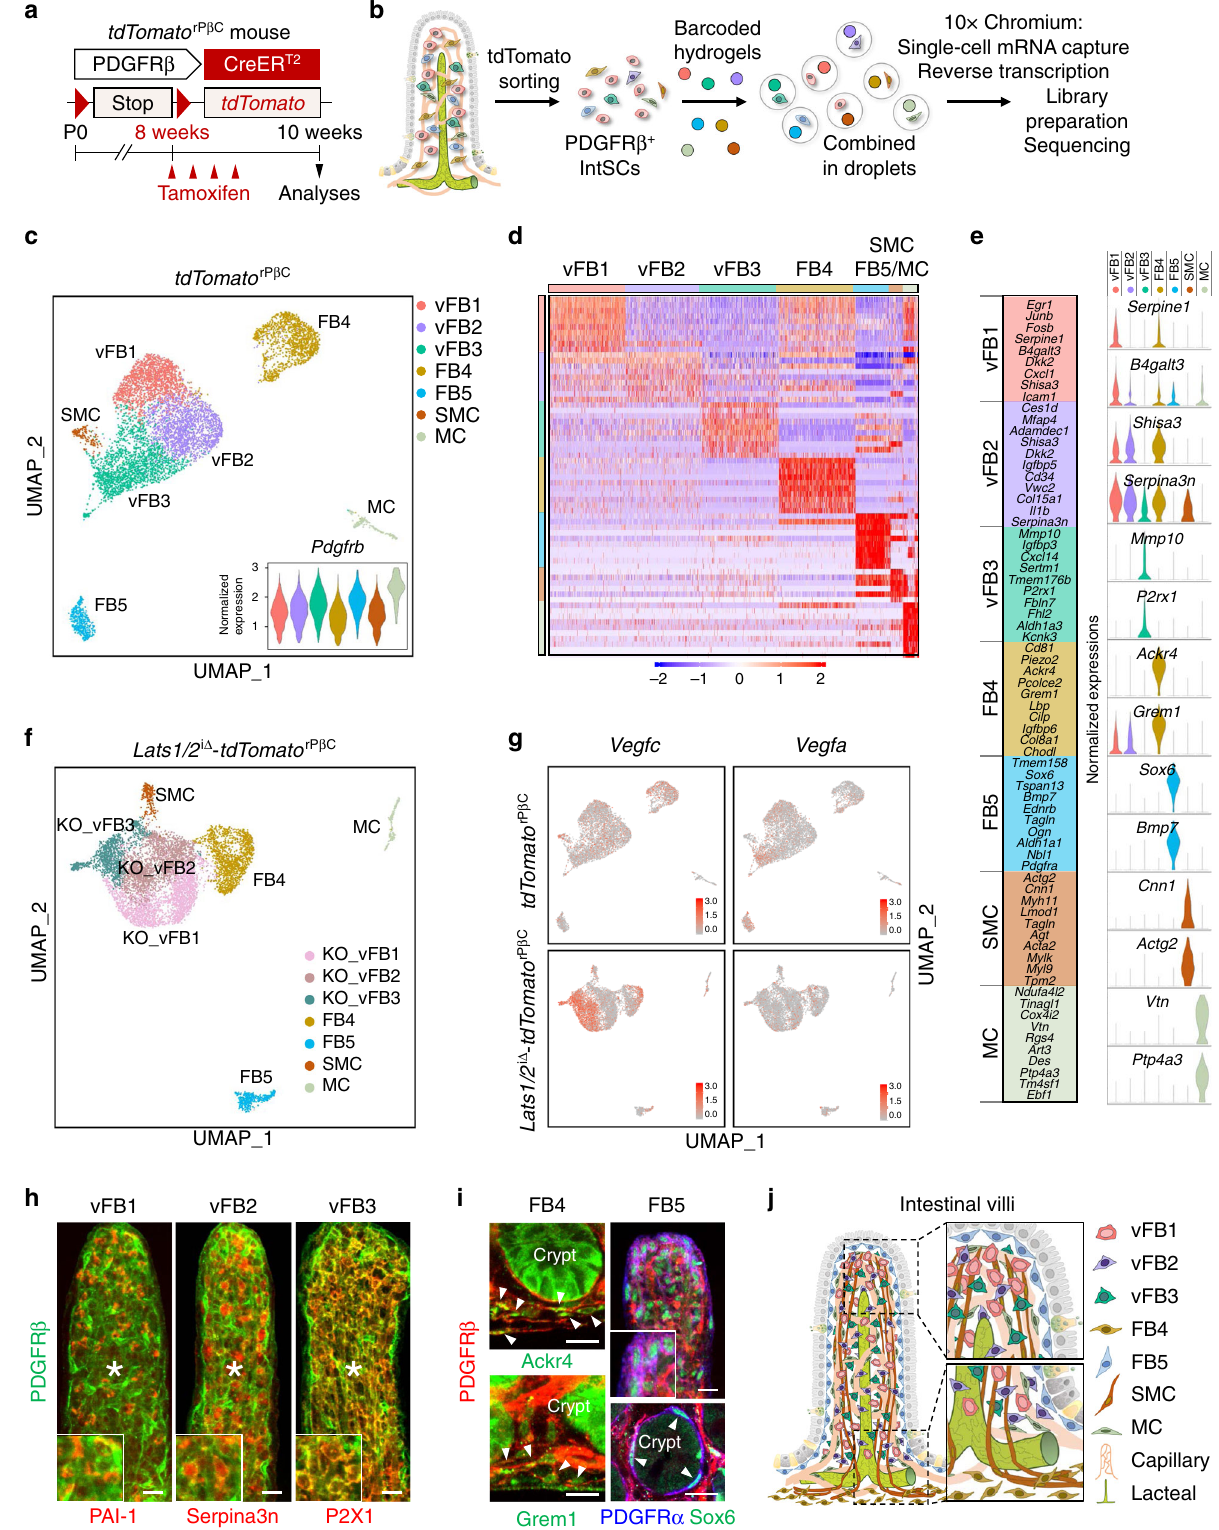
We also generated a single cell library from Lats1/2 i Δ - tdTomato rP β C mice (KO_) to delineate the villi PDGFR β + cells that secrete VEGF-C upon YAP/TAZ hyperactivation, and found seven distinct PDGFR β + IntSC clusters as observed in tdToma- to rP β C mice (Fig. 7f and Supplementary Fig. 16a, b).